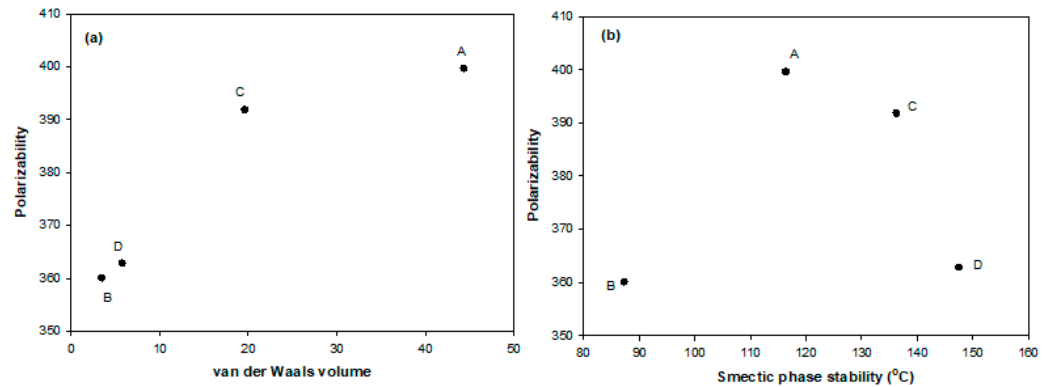
Figure 8. Correlation between the polarizability against ( a ) the van der Waal volume of terminal X and ( b ) the smectic mesophase stability T SmA.